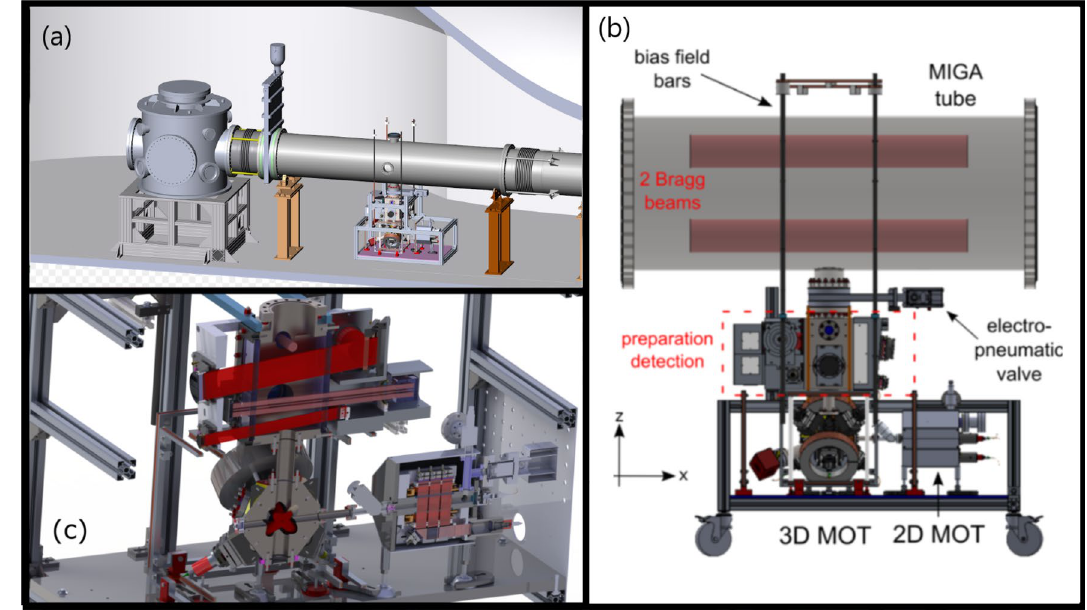
Figure 1. Overview of the MIGA instrument. ( a ) CAD view of the turret at the extremity of one of the two orthogonal 150-m long vacuum tubes of MIGA; one cold-atom system is shown on the right without its magnetic shields. The vertical panels represent valves to isolate the tubes from the chamber hosting the optics. ( b ) CAD drawing of the cold-atom source with a section of the vacuum tube (diameter: 500 mm); the two red cylinders represent the Bragg beams used to drive the atom interferometer and separated by 30.6 cm. The distance from the ground to the bottom of the vacuum tube is about 1 meter. ( c ) Sectional view of the core of the cold-atom source: a 2D MOT (right) loads a 3D MOT (center) from which the atoms are launched vertically. On their way up, they pass through various light beams to prepare their quantum state (see text). The interferometer region doesn’t appear on this